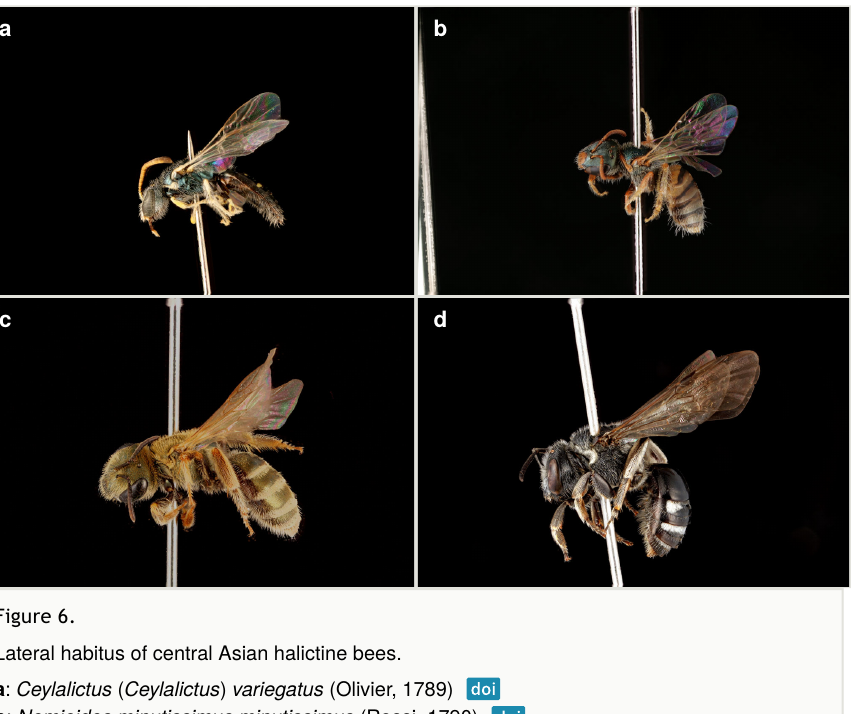
Figure 6. Lateral habitus of central Asian halictine